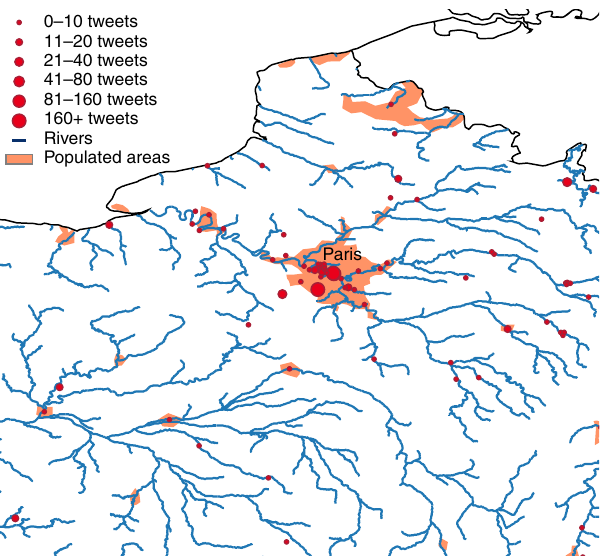
Fig. 2 Social media and fl ooding. Number of fl ood-related Twitter messages ( “ tweets ” ) during the January 2018 fl oods in France. Advances in social media analytics are used to detect and monitor fl oods earlier, allowing for more effective response ( fi gure produced by the author using data from the TAGGS 24 model, accessible through the Global Flood Monitor -